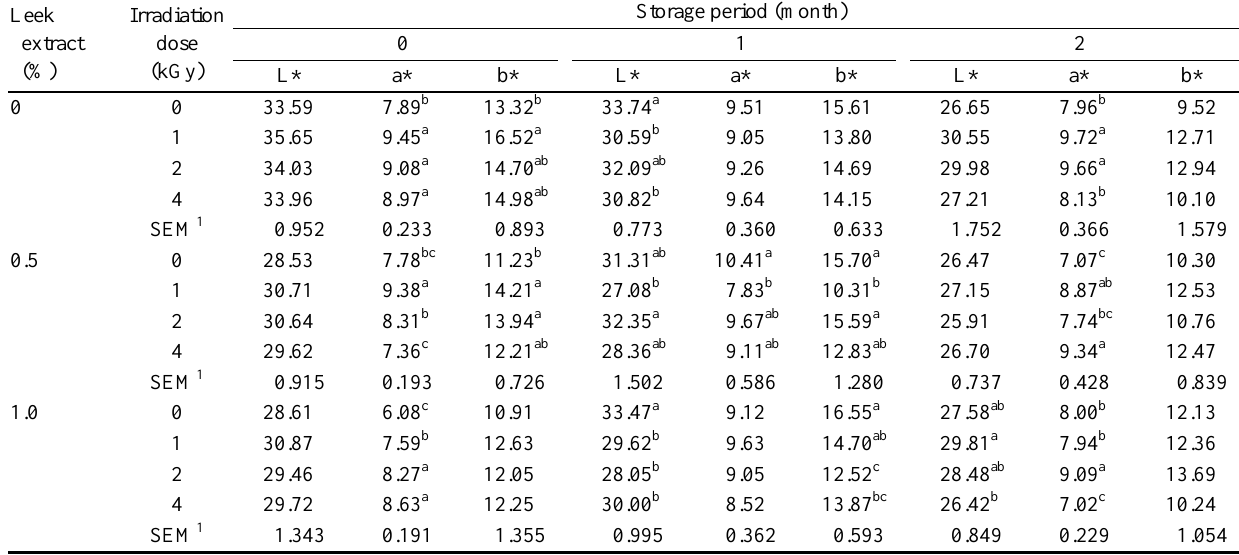
Table 3. Hunter color value of the electron beam irradiated pork jerky with added leek extract during storage for 2 months Leek extract (%)